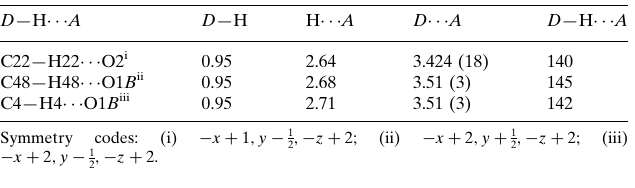
Hydrogen-bond geometry (A˚ , (cid:2)